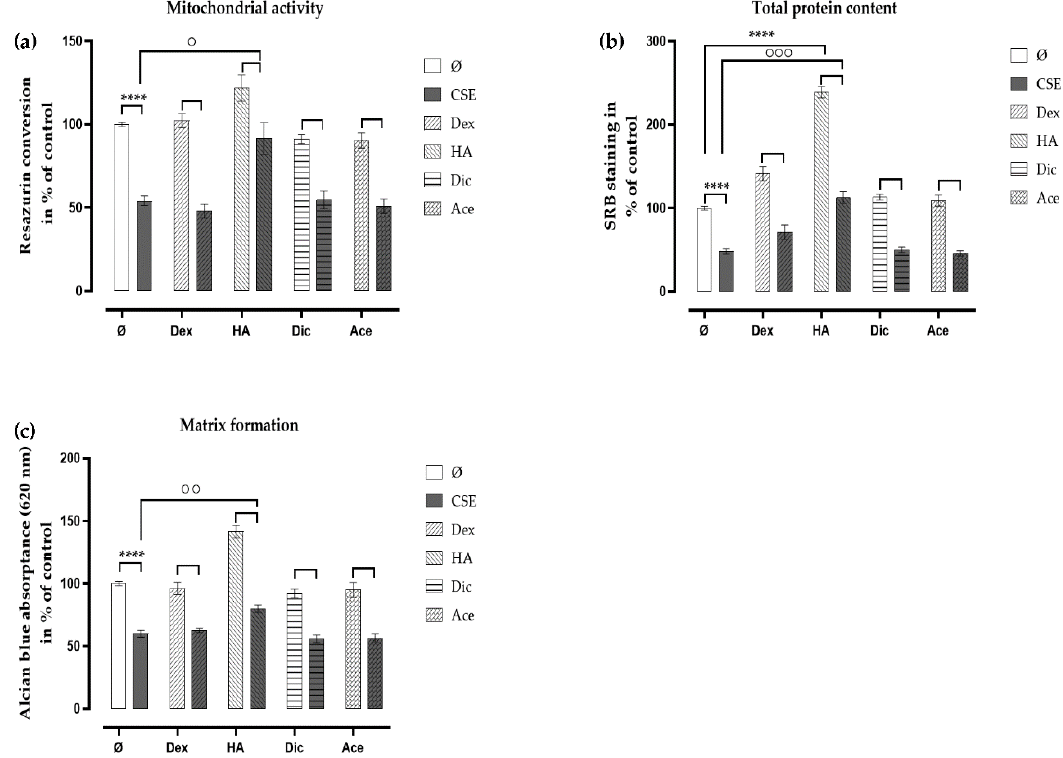
Figure 6. Diclofenac (Dic) and acetaminophen (Ace) had no additional adverse e ff ect on CSE-impaired primary human chondrocytes. Cells ( N = 3, n = 3) were incubated with Dex (4 µ g / mL), HA (5 mg / mL), Dic (1 µ g / mL), or Ace (10 µ g / mL) with or without 10% CSE. After 7 days of treatment, the viability of the cells was measured by ( a ) mitochondrial activity (resazurin conversion) and ( b ) total protein content (SRB staining). ( c ) Matrix formation was quantified by resolving the Alcian blue staining. Results are given as fold of control (untreated cells) and presented as mean ± SEM. * p < 0.05, **** p < 0.0001 compared to untreated cells, ◦ p < 0.05, ◦◦ p < 0.01, ◦◦◦ p < 0.001 compared to cells treated with CSE alone.